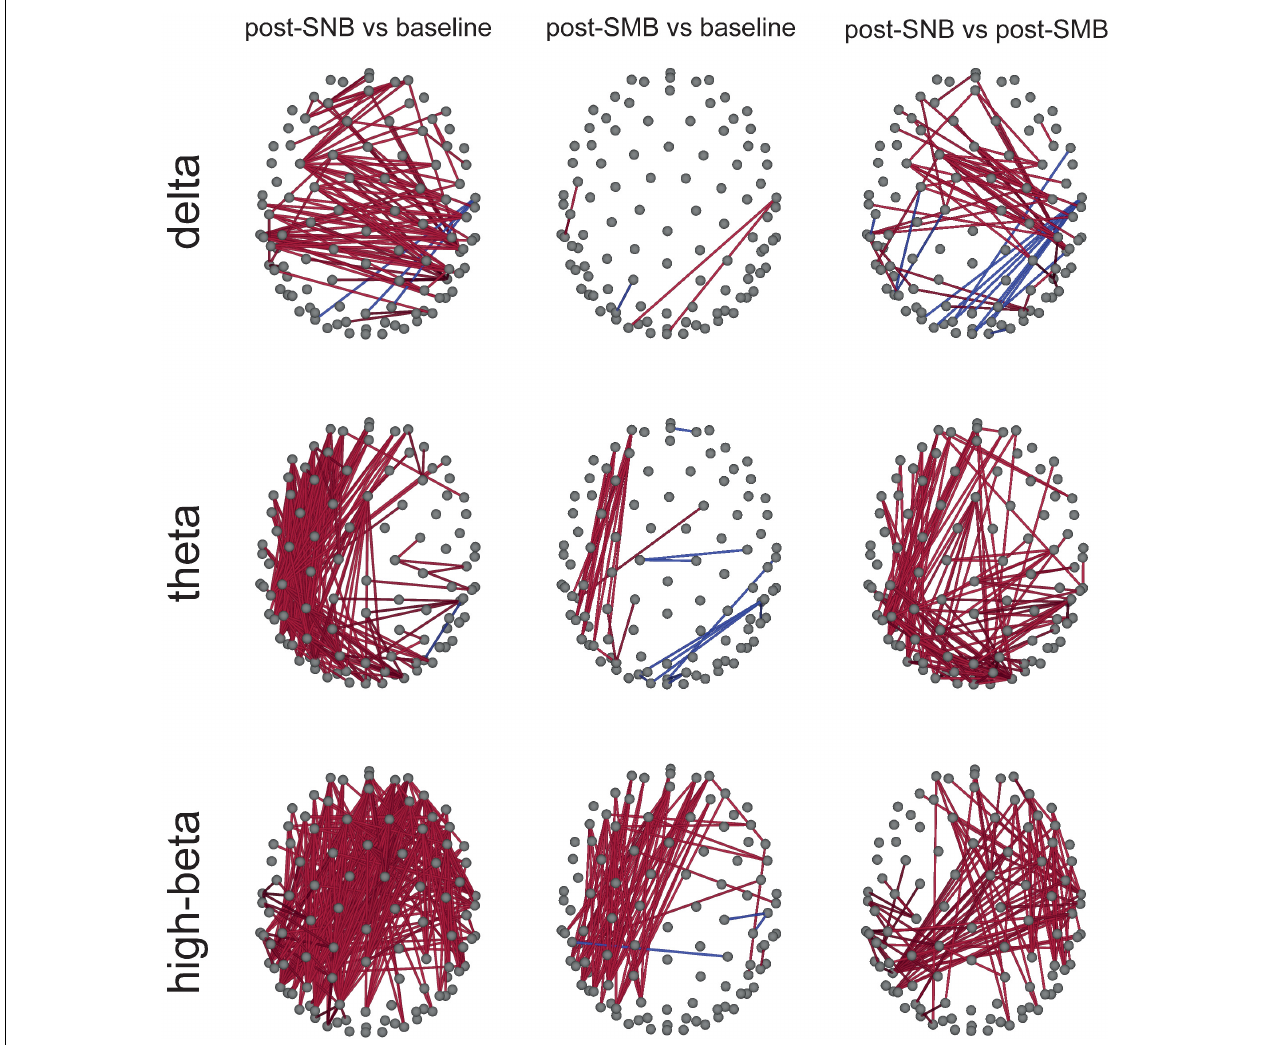
FIGURE 3 | Heightened connectivity in slow- (delta-theta) and high-(high-beta) frequency bands after SNB. Significant connectivity differences between couples of phases (post-SNB, post-SMB, and baseline) are presented for delta, theta, and high-beta bands. Red lines indicate significant comparisons where the former phase value is higher than that related to the latter phase; blue lines indicate the opposite